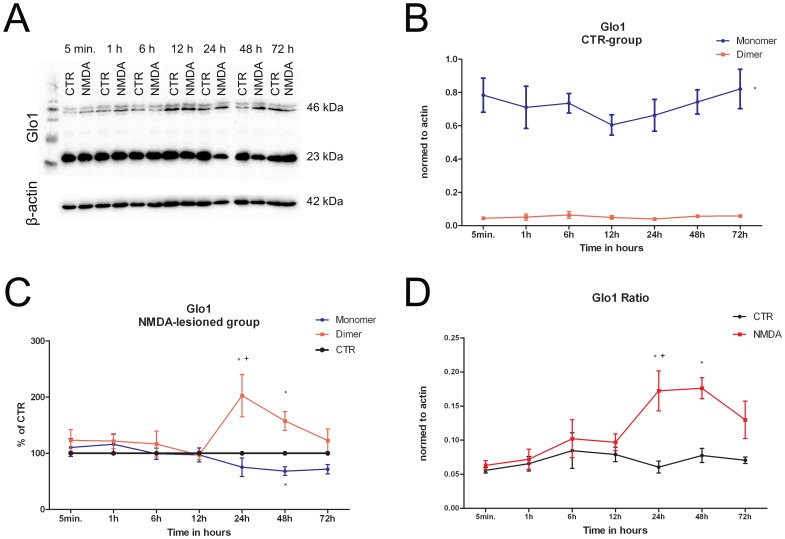
Time-dependent protein changes of Glo1 in control- and excitotoxically– lesioned OHSC from rats.
A Representative Western blot of Glo1 and the related β-actin signals for standardisation. Glo1 antibody marked two bands: one with a molecular mass of 23 kDa referring to the monomer and a second with a molecular mass of 46 kDa representing the dimer of Glo1. B Temporal dynamics of Glo1 (monomer, dimer) in control OHSC normalised to their related β-actin values. No significant changes for Glo1 monomer and dimer were found over the examined time frame. However, at all investigated time points significant differences between monomer and dimer levels were present (p<0.0001). C Alterations of Glo1 (monomer, dimer, CTR) after excitotoxically-lesion in a time-dependent manner as normalised against β-actin values. Subsequently, monomer and dimer levels of the lesioned-group were normalised and presented in relation to their respective time controls which were set arbitrarily to 100%. The Glo1 monomer showed a significant difference at 48 h compared to time control (*, p<0.05). Statistically differences for the Glo1 dimer were found at 24 h and 48 h post-injury (*, 24 h, p<0.0001; 48 h, p<0.001) compared to monomer and time control. Furthermore, a significant increase in dimer levels was determined from 12 h to 24 h after NMDA-application (+, p<0.05). D The alteration of the Glo1 dimer/monomer (ratio) in OHSC as a time-dependent phenomenon of excitotoxicty. We observed a significant increase in the ratio of NMDA-group from 1 h to 24 h after NMDA-treatment (+, p<0.05). Moreover, significant differences between control- and NMDA-group were found at 24 h and 48 h after NMDA exposition (*, p<0.0001).